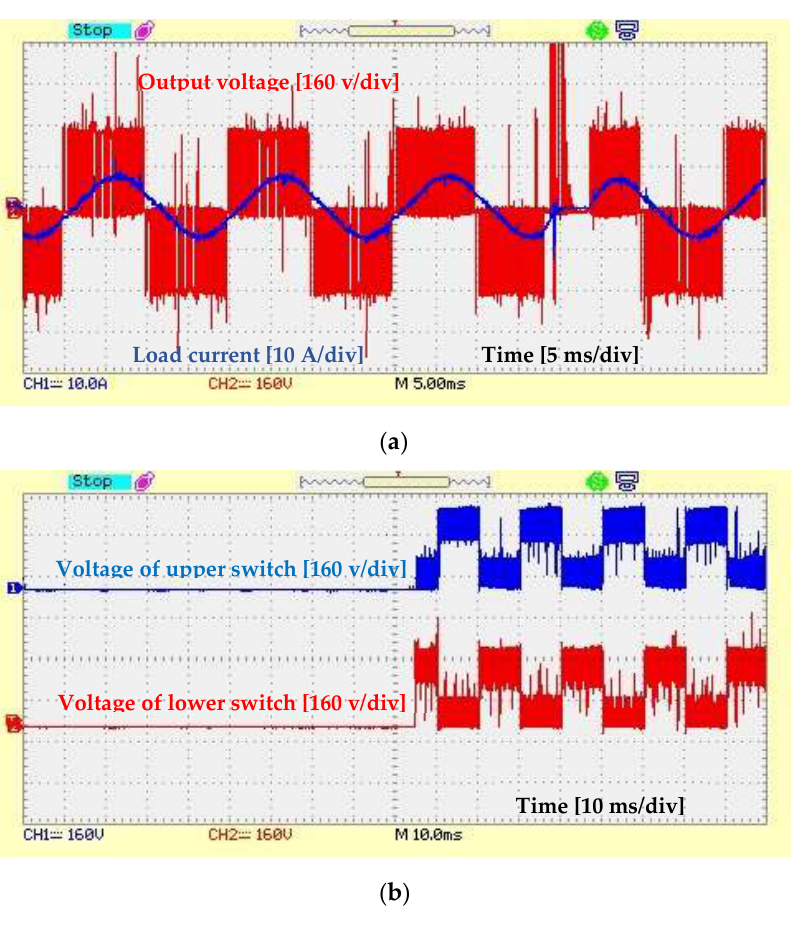
Figure 18. Performance measures of the proposed IFTPVI topology in the presence of a fault in the first leg; ( a ) output voltage and load current, and ( b ) voltage stresses of the reserve switches.